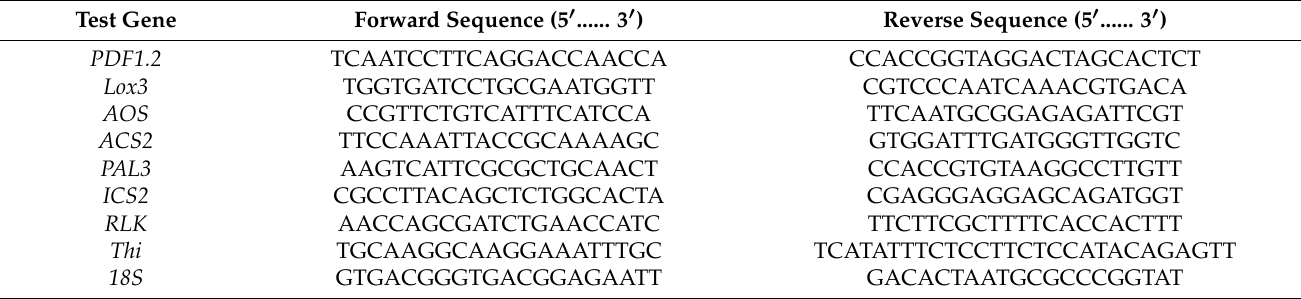
Table A1. Primers of all test genes JA, SA, ET used in RT-qPCR. Test Gene